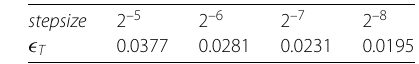
Table 4 Computational error at endpoint T = 1 for Example 5.3 with c =